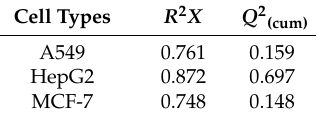
Table 2. The evaluation of explained variation ( R 2 X ) and predictive ability ( Q 2 (cum) ).